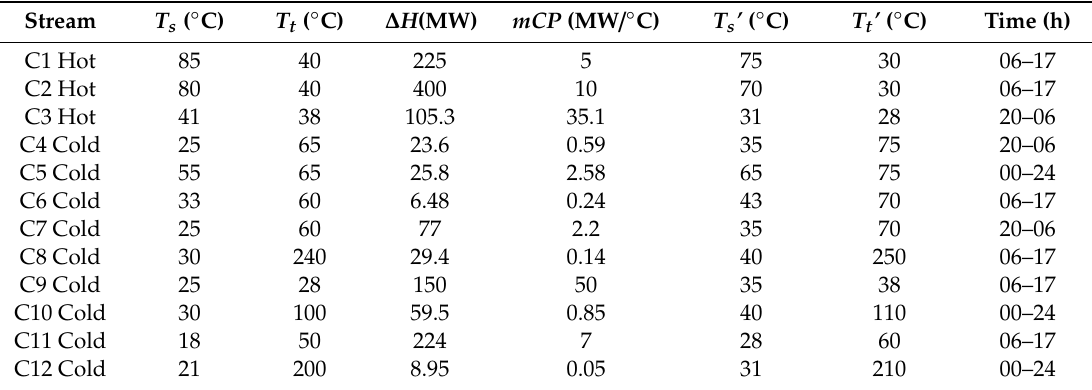
Table 2. Stream data for Industrial Plant A with min, pp T Table4. Streamdata forIndustrial PlantC with ∆ T min, pp = 20 ◦ C(modified from Jamaluddin et al. [27]). [27]).